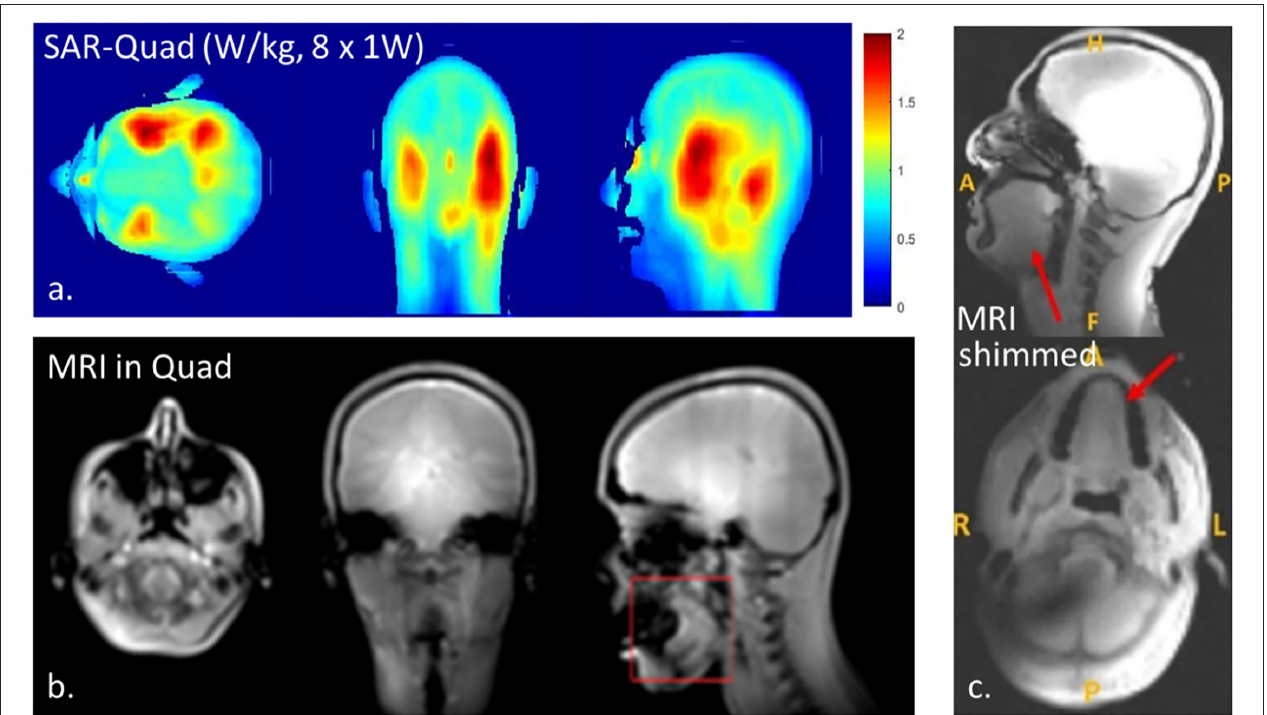
FIGURE 5 | Results with the 1 H dipole array indicating RF power deposition when driven in quadrature (a) , anatomical MRI when driven in quadrature (b) , and anatomical MRI when using constructive B + 1 interference (RF shimming, c ). Note that RF shimming in the tongue will result in B + 1 shading in certain areas of the brain (c) .